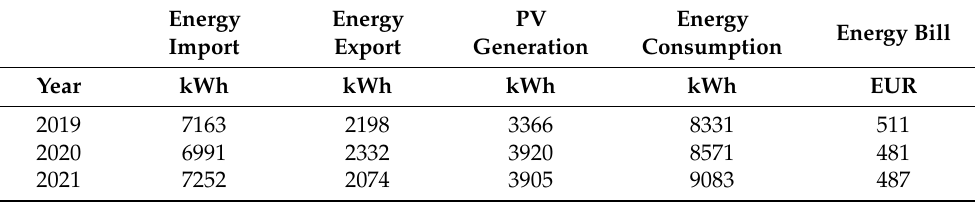
Table 10. Real energy flows and energy bills in years 2019–2021.